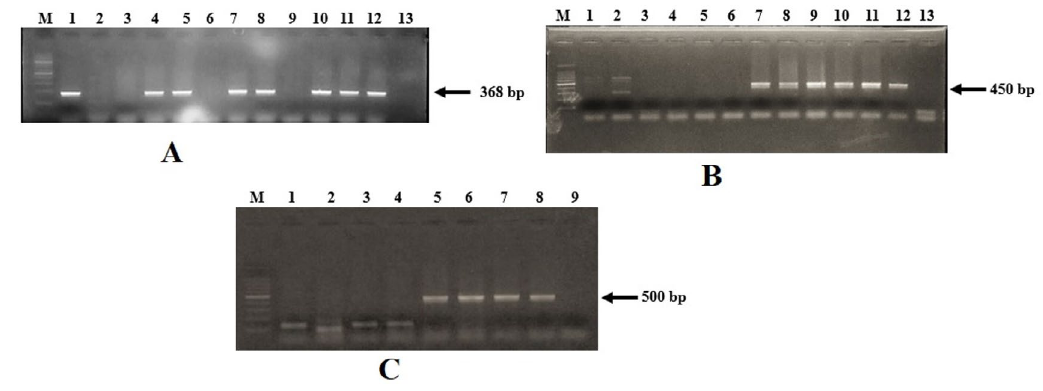
Fig 1. Agarose gel electrophoresis for the vibrio isolates Detection of toxR gene (A). Lane M: 1 kb DNA ladder (Thermo Fisher Scientific, USA); lanes 1-11: presumptive V. parahaemolyticus isolates from shrimp, water and sediment samples; lane 12: positive control ( V. parahaemolyticus AQ 4037); lane 13: negative control Detection of tlh gene (B). Lane M: 100 bp DNA ladder (Thermo Fisher Scientific, USA); lanes 1-3: isolates from sediment; lanes 4-5: isolates from water; lanes 6-8: isolates from hepatopancreas; lanes 9-11: isolates from shrimp tissue; lane 12: positive control ( V. parahaemolyticus AQ 4037); lane 13: negative control. Detection of trh gene (C). Lane M: 100 bp DNA ladder (Thermo Fisher Scientific, USA); lanes 1-2: isolates from shrimp tissue; lanes 3-4: isolates from water; lanes 5-6: isolates from hepatopancreas; lanes 7: isolates from sediment; lane 8: positive control ( V. parahaemolyticus AQ 4037); lane 9: negative